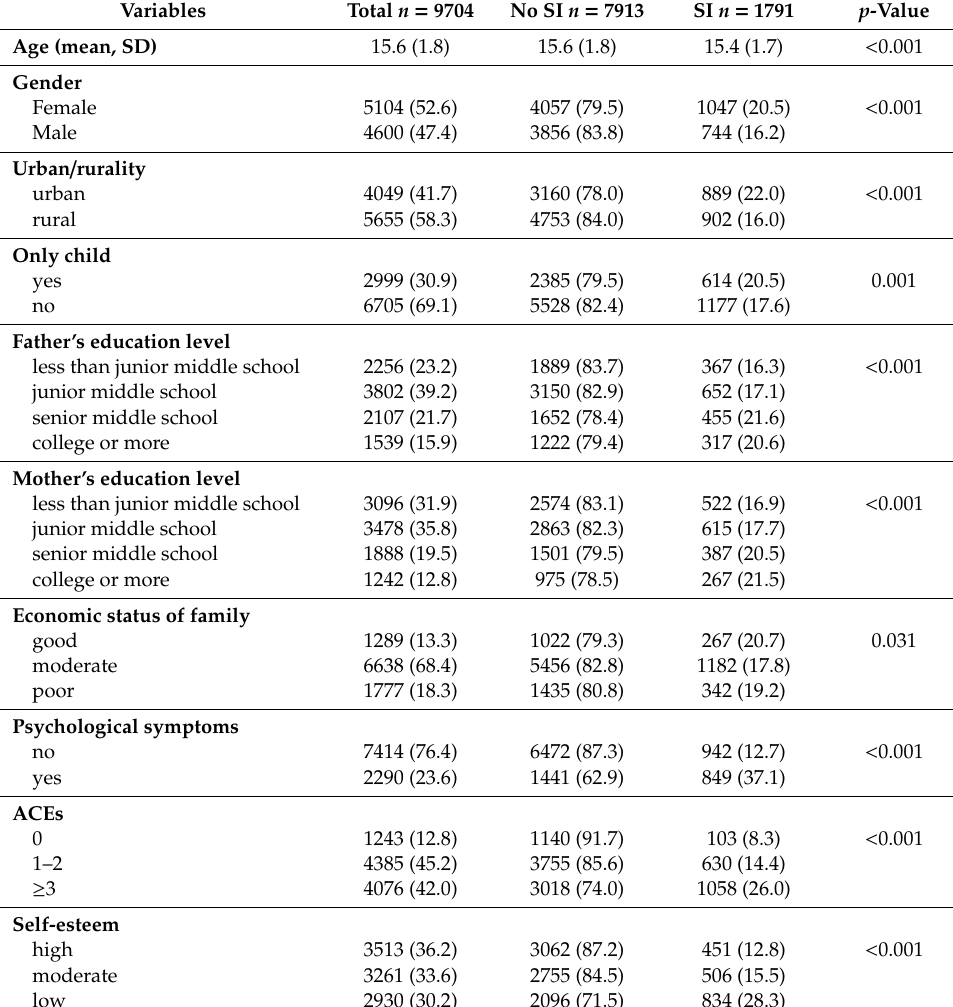
Table 1. Characteristics of participants by SI, n (%): 15-school study,